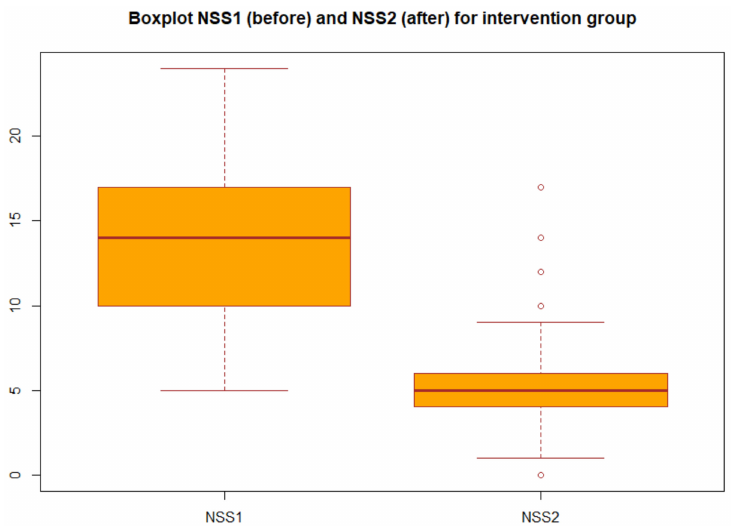
Figure 1. Boxplot of NSS before and after treatment in the intervention group (group A).